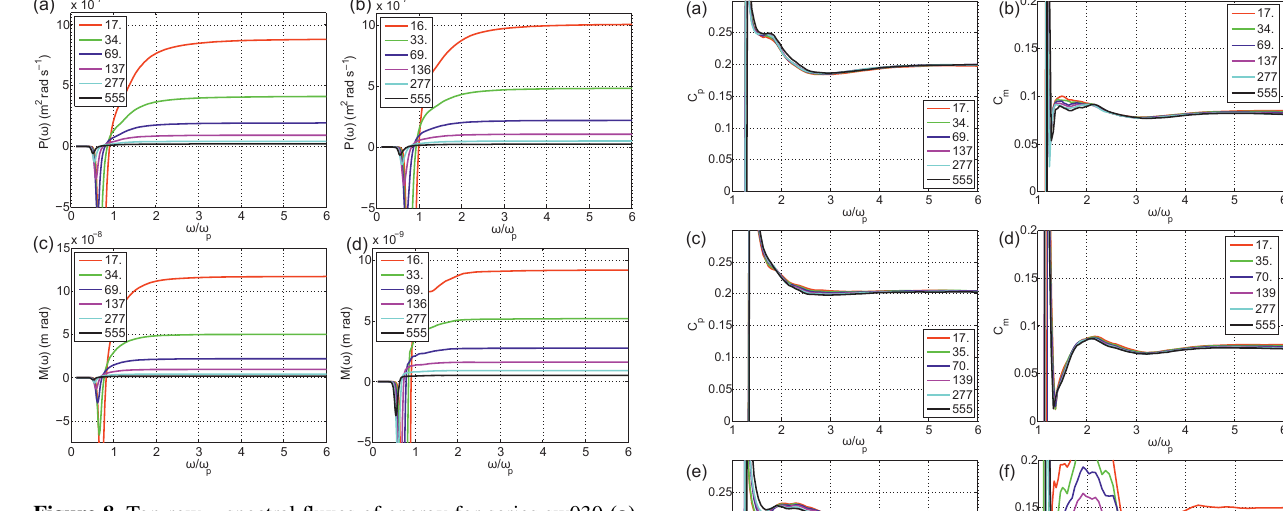
Figure 8. Top row – spectral fluxes of energy for series sw030 (a) and sw330 (b) ; bottom row – spectral fluxes of momentum for series sw030 (c) and sw330 (d) at different times (legend, in hours).